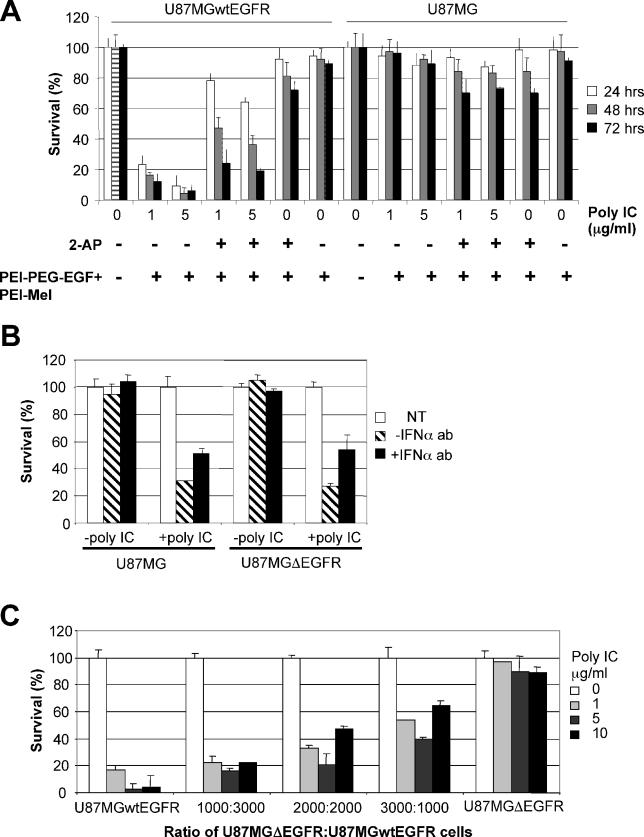
Cell Killing Mechanisms(A) Protection of the cells by 2-AP. Cells were grown as in Figure 1A. Cells were then transfected with poly IC at the indicated concentrations using PEI-PEG-EGF+PEI-Mel complexes. Where indicated, 2-AP (5 mM) was added 18 h before transfection and the medium was replaced every 24 h with medium containing fresh 2-AP. Viability was measured by the Methylene Blue assay [8].(B) In vitro bystander effect. U87MGwtEGFR cells were grown and transfected as described in Methods. U87MG and U87MGΔEGFR “indicator” cells were grown in duplicates in 96-well plates. Medium of the “indicator cells” was then partially replaced by the medium collected from the transfected (+poly IC) or untransfected (-poly IC) U87MGwtEGFR cells (Methods). Where indicated the medium was preincubated with neutralizing polyclonal anti IFNα antibody. In NT samples, medium was not replaced.(C) A total of 4,000 U87MGwtEGFR and U87MGΔEGFR cells were seeded in duplicate onto a 96-well plate at the indicated ratios and grown overnight. Cells were then transfected with poly IC at the indicated concentrations using PEI-PEG-EGF+PEI-Mel conjugates. Cell survival was measured by the Methylene Blue assay 96 h after transfection.